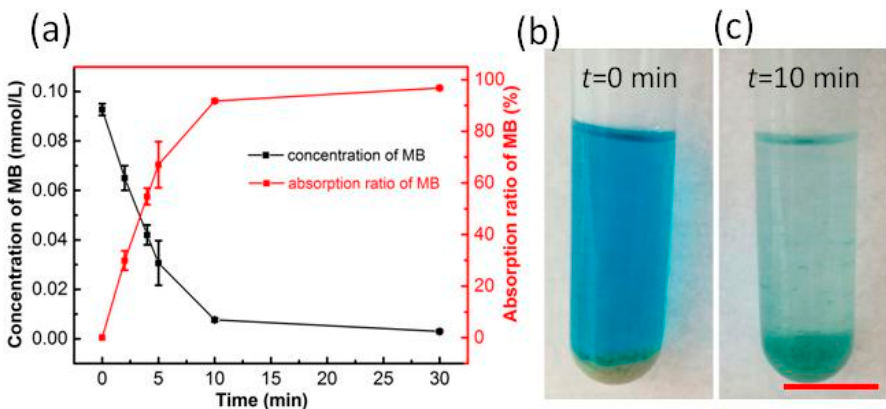
Figure 6. Adsorption test of the porous RF microspheres; ( a ) adsorption curve of methylene blue; ( b ) before adsorption photos; ( c ) after 10 min adsorption. The scale bar is 1.0 cm.